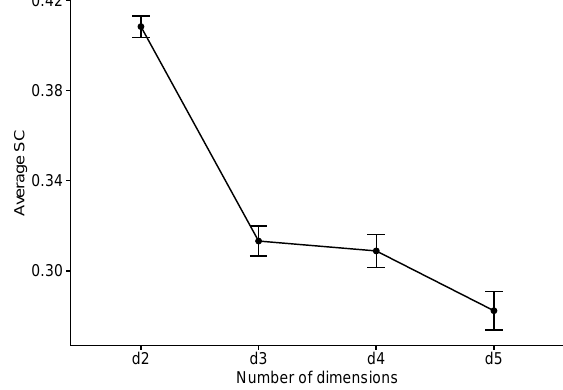
Figure 3. Average silhouette coefficent (SC) by number of dimensions produced by